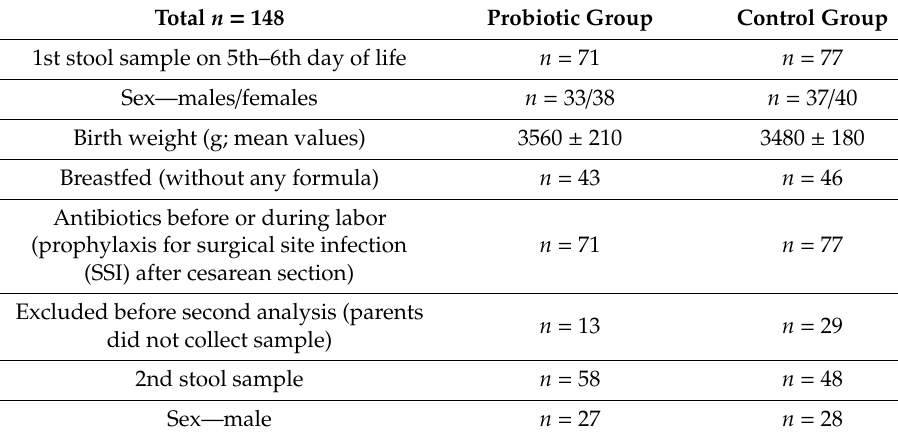
Table 1. Characteristics of the study